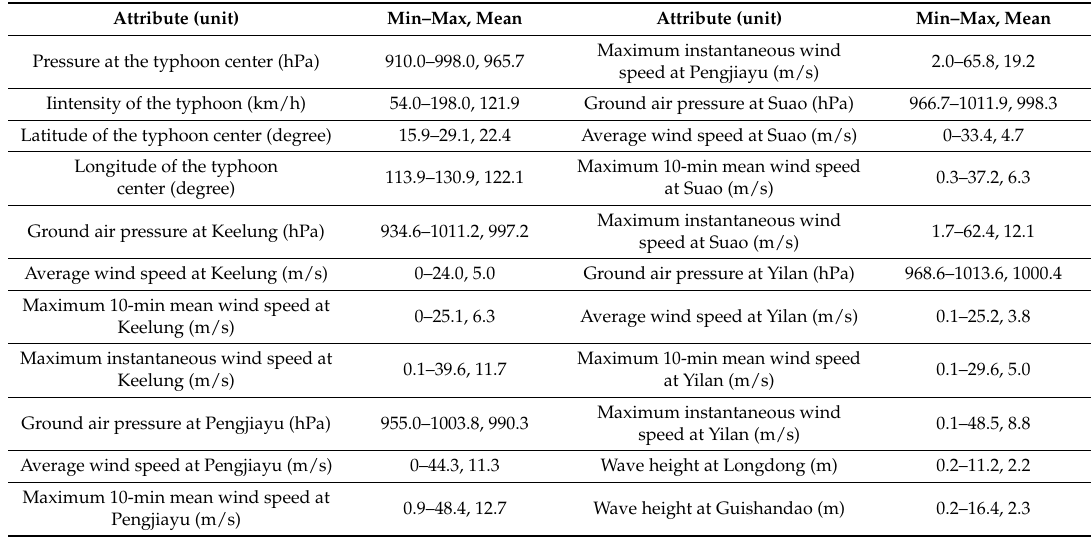
Table 2. Statistical attributes of the typhoons, meteorological data, and buoy-obtained